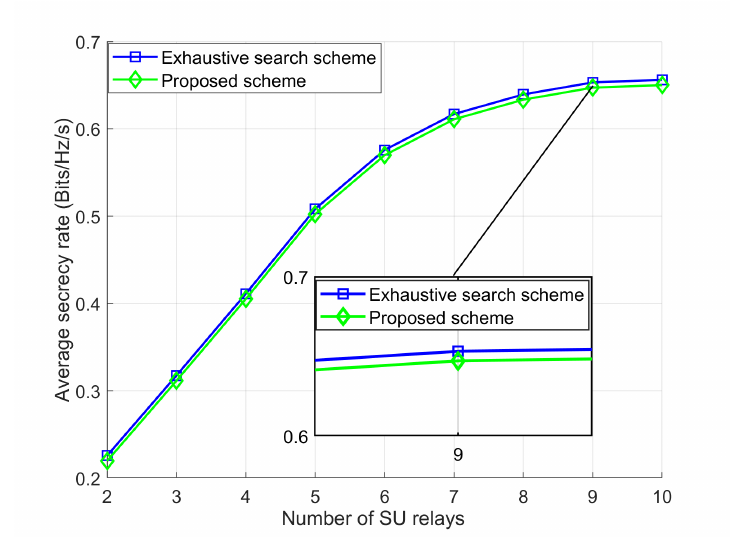
Figure 3. Average SR of the proposed scheme compared with the exhaustive search